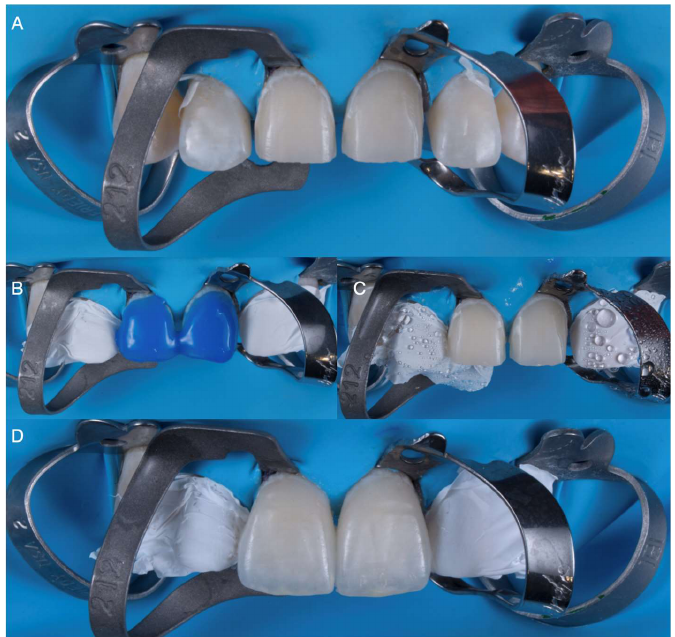
Figure 7. Bonding–luting process. ( A ) Rubber dam isolation. ( B ) Phosphoric acid treatment of pre- pared tooth surface. ( C ) Rinsed. ( D ) Final cementation of veneers.